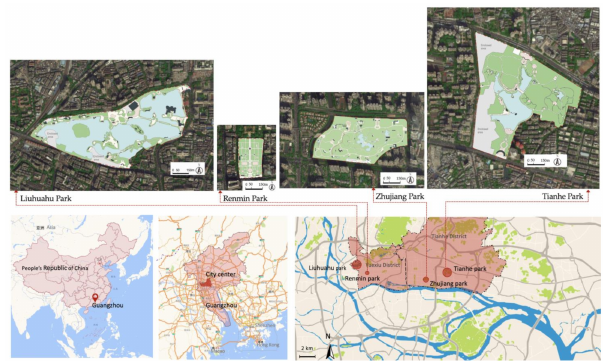
Figure 3. Locations and master plans of parks studied in Guangzhou,